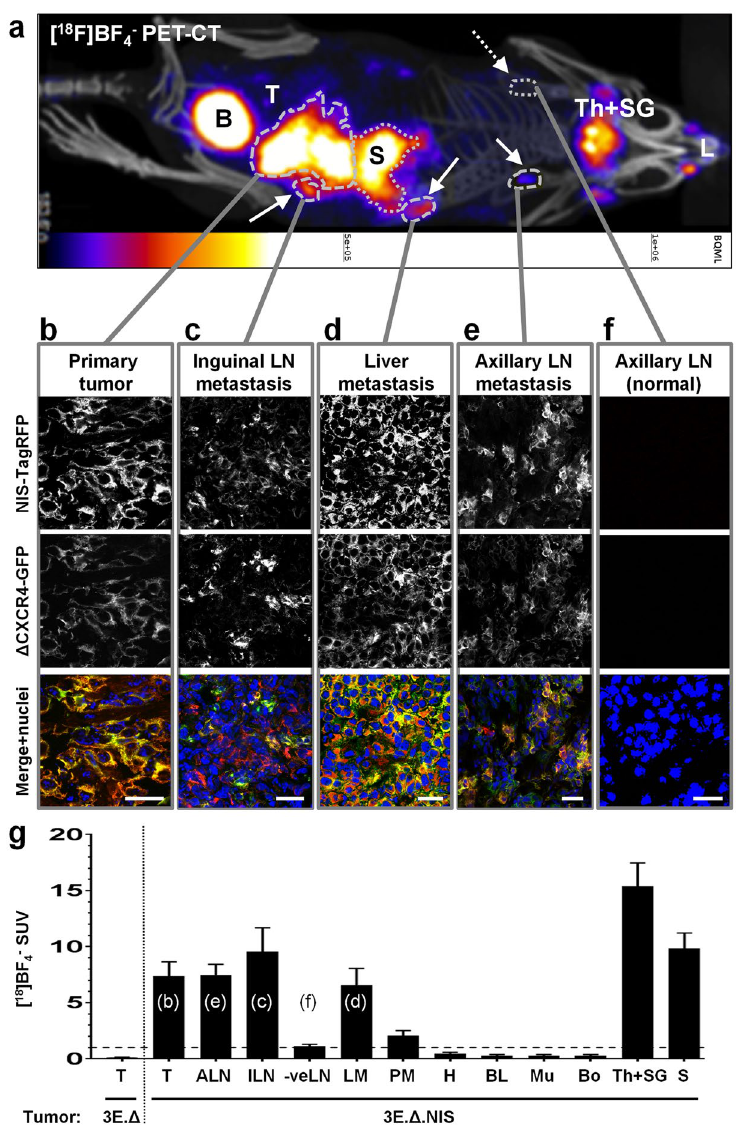
Figure 5. Combination of a NIS-expressing tumor model with [ 18 F]BF 4 − -PET enables reliable and sensitive metastasis detection. ( a ) Representative maximum intensity projection image (overlaid on CT) of a [ 18 F] BF 4 − -PET/CT scan of an animal growing a primary tumor established from 3E. Δ -NIS cells. Abbreviations are: bladder (B), lachrymal glands (L), stomach (S; dotted), thyroid and salivary glands (Th + SG), and primary tumor (T). Full arrows point to metastatic sites and include the following objects (dashed): left inguinal LN, liver metastasis, left axillary LN. Dotted arrow points to the site of the right axillary LN (no PET signal) and was later confirmed to be metastasis-free (see f). ( b–f ) Positivity/negativity for metastasis was determined from the PET/CT scans and tissues were subsequently harvested, γ -counted and sectioned; confocal microscopy confirmed the PET-based classifications in all cases. Confocal fluorescence microscopy revealed cancer cell presence by virtue of the fluorescence signals of NIS-TagRFP (top) and truncated CXCR4-GFP (middle). Data show the expected plasma membrane localization of both fusion proteins, thereby identifying cancer cells, and that signals belong to intact cells (membrane signals circumscribe Hoechst33342-stained cell nuclei (bottom)). Micrographs shown belong to the representative animal from ( a ) and represent ( b ) the primary tumor, ( c ) metastasis in the inguinal LN, ( d ) metastasis in the liver, ( e ) metastasis in the axillary LN, and ( f ) the contralateral axillary LN, which was not affected by metastasis (no signals in the [ 18 F]BF 4 − -PET and fluorescence microscopy data). Scale bars are 25 μ m. ( g ) [ 18 F]BF 4 − biodistribution data expressed as SUV as determined by γ -counting post tissue harvesting. Abbreviations are (from left to right): primary tumors (T), axillary lymph nodes (cancer cell-positive; ALN), inguinal lymph nodes (cancer cell-positive; ILN), metastasis- free lymph nodes (-veLN), liver metastases (LM), peritoneal metastases (PM), heart (H), blood (BL), muscle (Mu), bone (whole femur; Bo), thyroid and salivary glands combined (Th + SG), and stomach (S). Shown are pooled data of 3E. Δ -NIS tumor (N = 8, right of dotted line) and 3E. Δ tumor animals (NIS-negative tumors, N = 6). Error bars represent SEM. Lower case letters in brackets relate the figure panels (b–f) to the columns in which they were quantified together with equivalent tissues from other